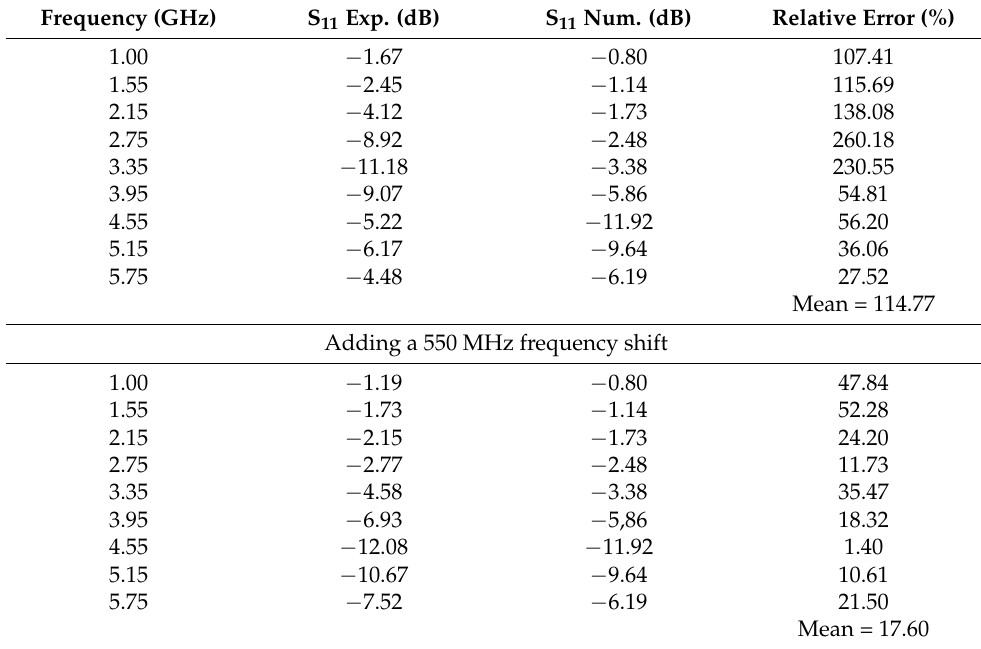
Table 2. Comparison between S 11 experimental and numerical results.